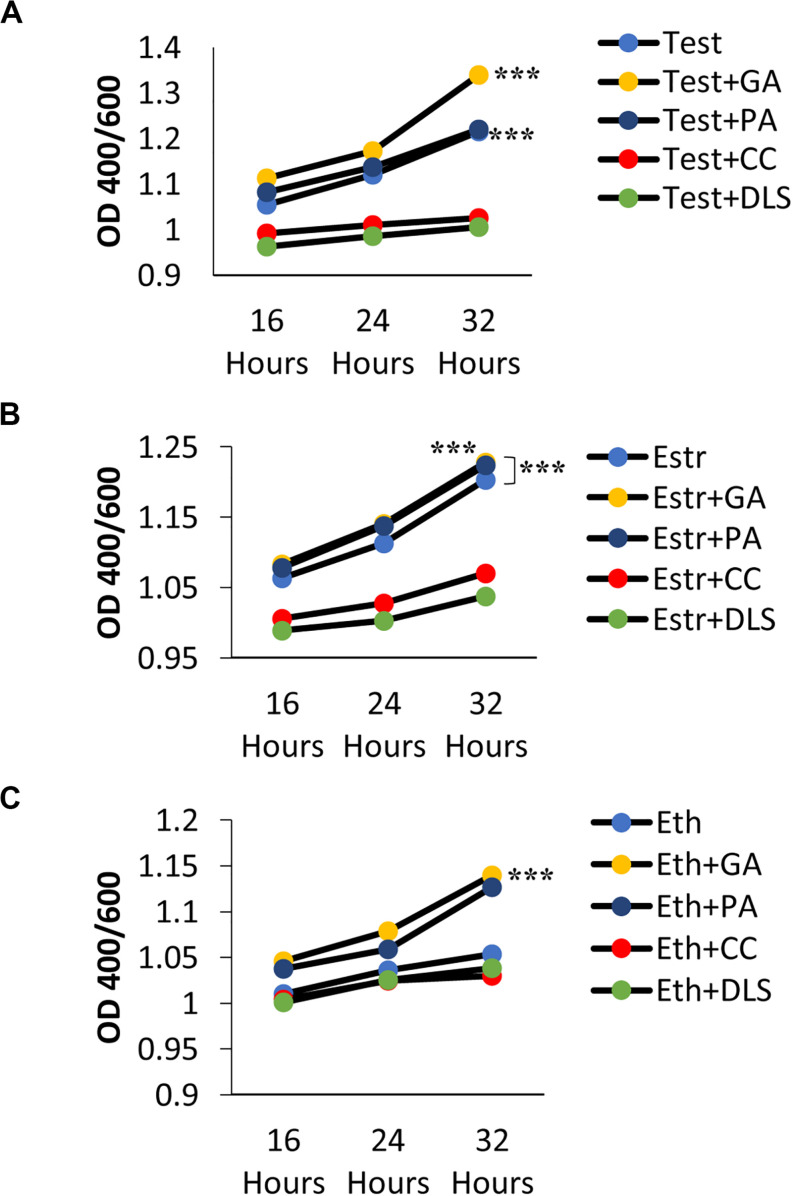
Melanization of C. neoformans grown in the presence of various additives/inhibitors and steroid hormones. (A) Testosterone, (B) Estrogen, (C) Ethanol. Absorbances were measured at an optical density of 400 and 600 nm. Error bars represent the standard deviation. Data is representative of three independent experiments. Statistical significance is represented as follows: ***p < 0.0001 comparing Test alone and Test + GA to all other treatments. ***p < 0.0001 comparing Estr + GA to Estr alone and Estr + PA to all other treatments. ****p < 0.0001 comparing Eth + GA to all other treatments using linear regression. Test, Testosterone; GA, Gibberellic Acid; PA, Pantothenic Acid; CC, Chlormequat Chloride; DS/DLS, DL-Serine.